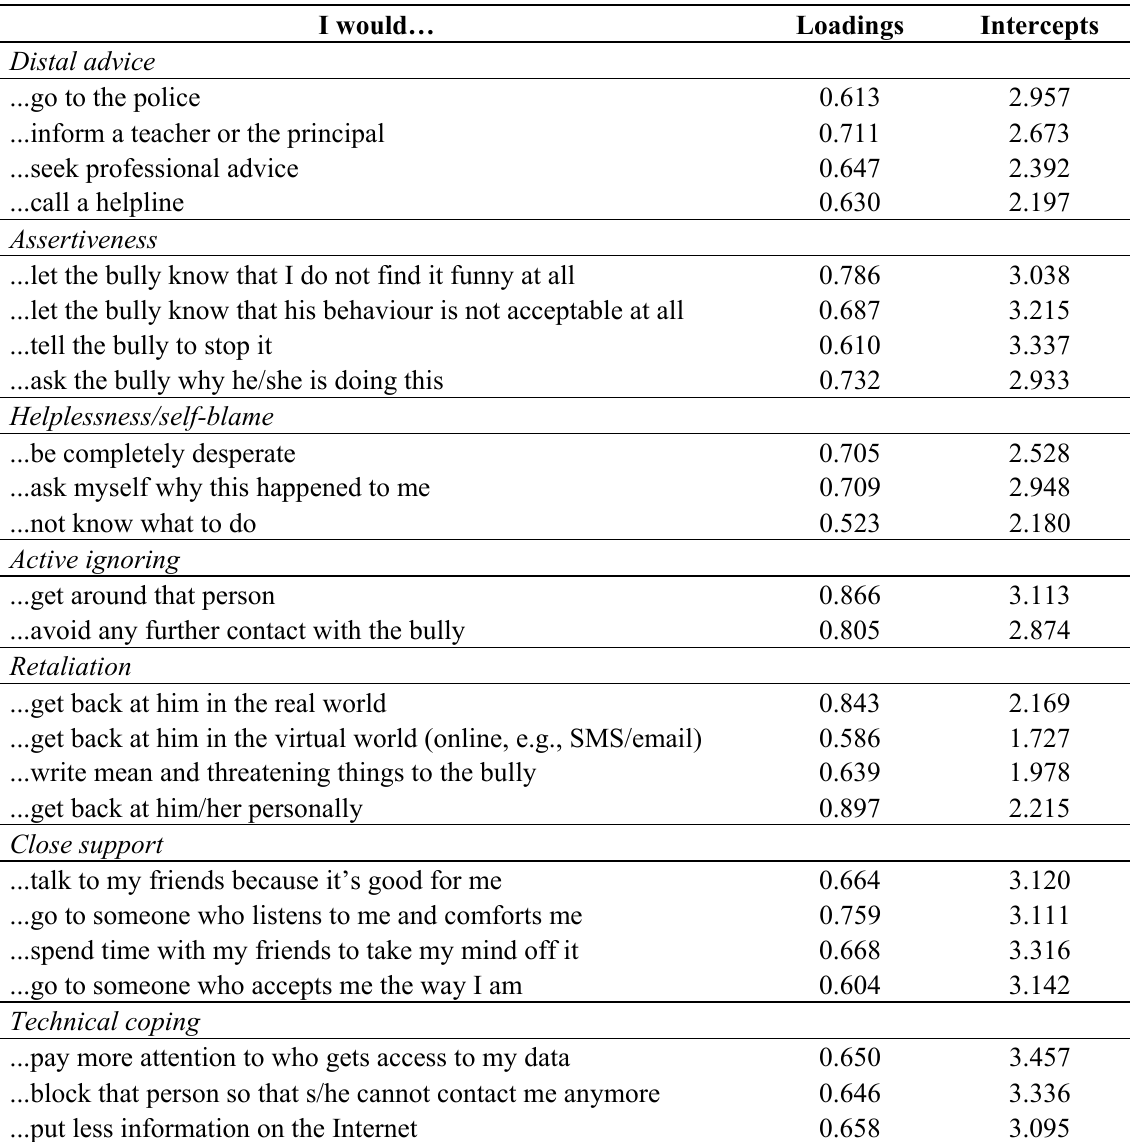
Table 5. Standardized factor loadings and unstandardized item intercepts for the Italian sample (based on the data from Stage 4; N =